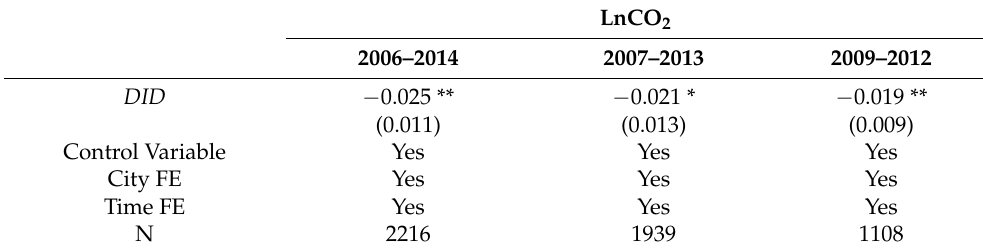
Table 7. Sample adjustment.